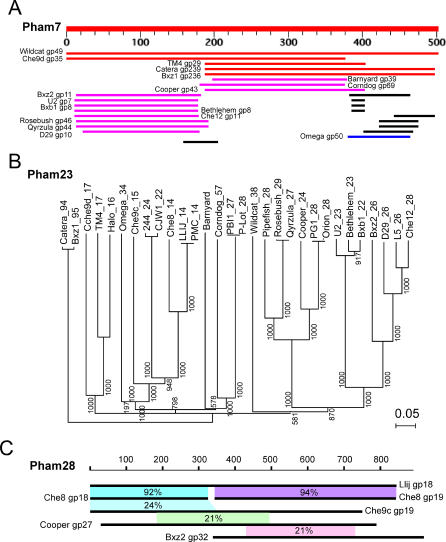
Complex Relationships within Highly Abundant Mycobacteriophage Phamilies(A) Complex relationships among members of the Pham7 (Lysin A) phamily. The output of a BLAST comparison of Wildcat gp49 against other mycobacteriophage proteins shows that only 16 other mycobacteriophage proteins are matched and that these correspond to different parts of Wildcat gp49. Colored bars represent the strength of the matches, with red being the strongest, followed by purple, blue, and black.(B) Phylogenetic relationships between members of mycobacteriophage Pham23 (tape-measure protein; Tmp). Amino acid sequences for each of the 30 constituent members of Pham23 were aligned using ClustalW and the unrooted phylogenetic relationships represented using NJTree. Bootstrap values from 1,000 reiterations are shown.(C) Chimerism in Pham28 (minor tail) proteins. Llij gp18 is related to both gp18 and gp19 of phage Che8 at high levels of amino acid sequence identity, and these proteins are related in turn to other members of Pham28 as shown.